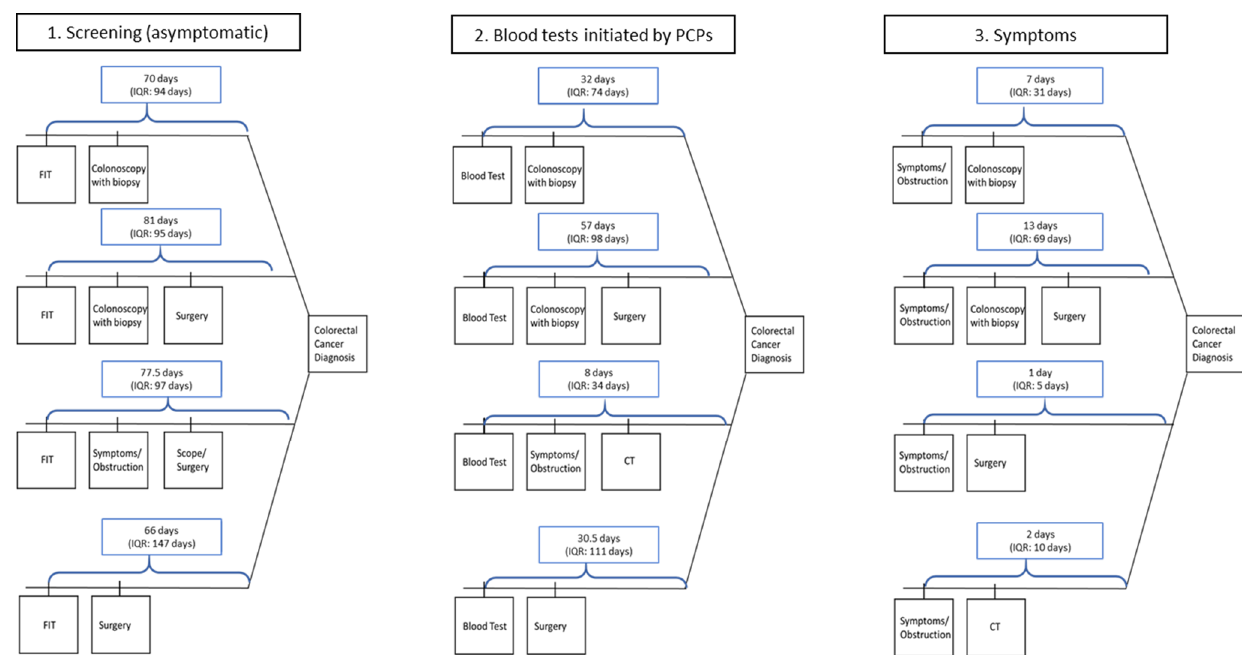
Figure 2. Refined diagnostic pathway frameworks among 7545 patients diagnosed with colorectal cancer between 1 Janu- ary 2016 and 1 July 2020 in Alberta, Canada. PCP = Primary care physicians.